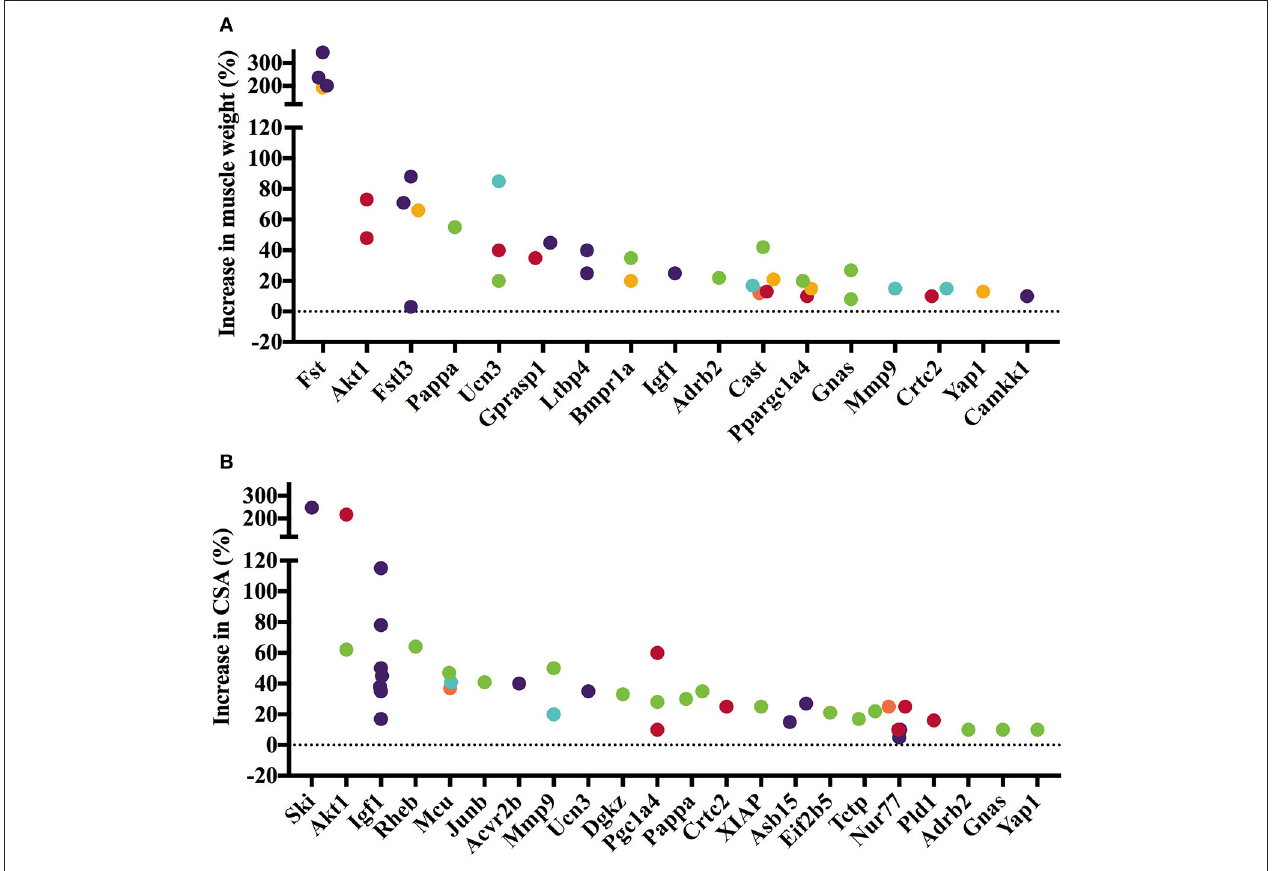
FIGURE 1 | Gene knock-in or overexpression increases muscle weight and cross-sectional area (CSA). Increase in muscle weight (A) and fiber or muscle CSA (B) differs across genes and between muscles. Individual muscles are color-coded as follows: • Gastrocnemius, • Soleus, • Tibialis anterior, • Quadriceps, • Extensor digitorum longus, • Other. Data is based on values collected in Supplementary Table S2.